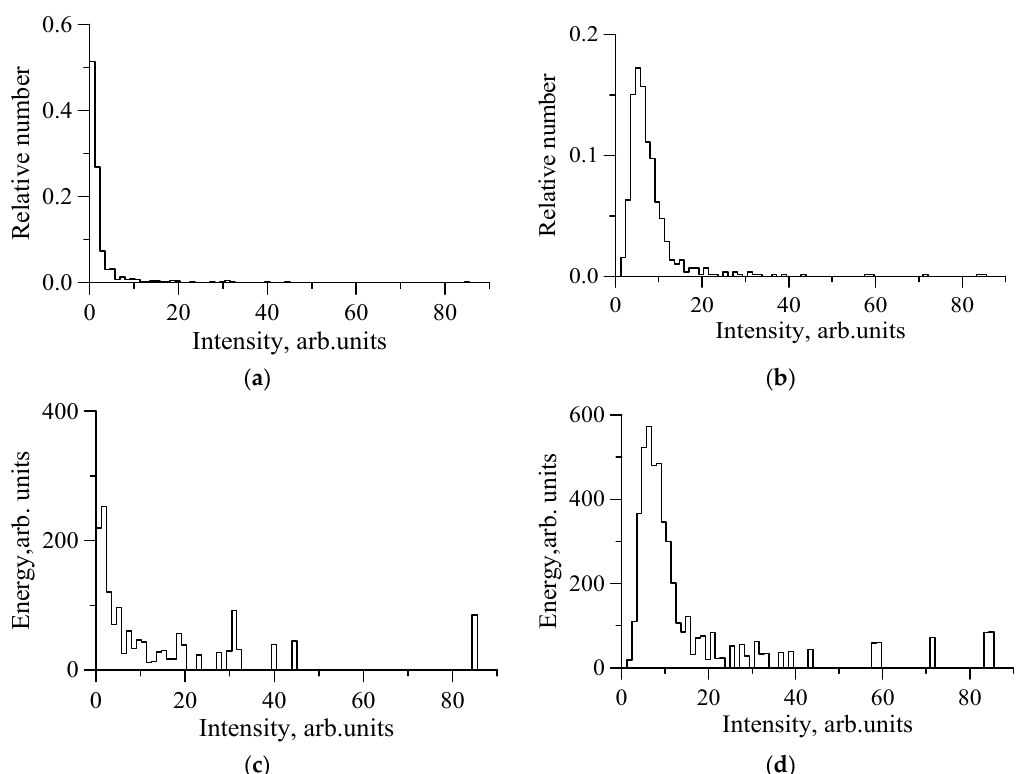
Figure 6. Histograms of instantaneous backscatter values ( a , b ) and diagrams of the total energy of local radar return within a given intensity interval ( c , d ) vs. intensity of local backscatter value at HH polarization ( a , c ) and VV polarization ( b , d ) for the case shown in Figure 5.